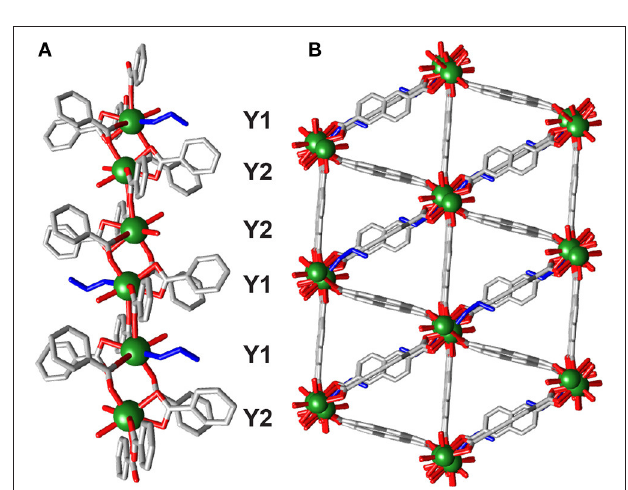
FIGURE 5 | The crystal structure of 6 . (A) One dimensional chain SBU, with coordinating ethanol colored blue. (B) Packing structure showing significant void space, with ordered DMF guests removed for